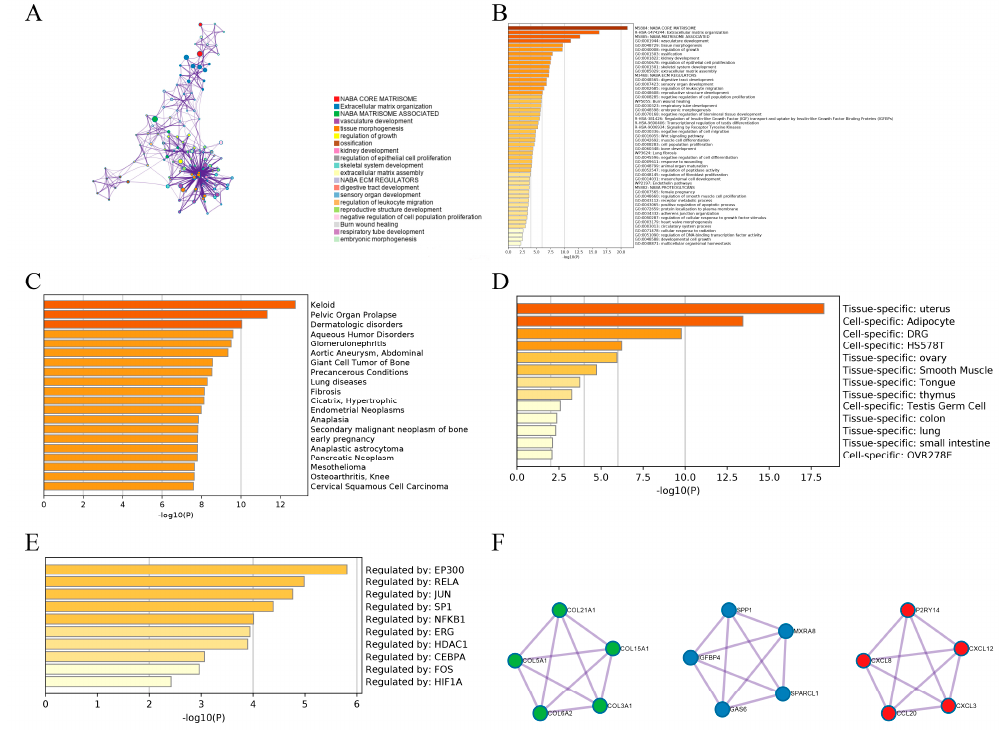
Figure 2. PPI network based on Metascape. ( A ) Network diagrams of the enrichment pathway and process of EC. ( B ) Bar plot of the enrichment pathway and process of EC. ( C ) Bar plot of enrichment on DisGeNET. ( D ) Bar plot of enrichment on PaGenBase. ( E ) Bar chart of enrichment on TRRUST. ( F ) Three sub-modules of